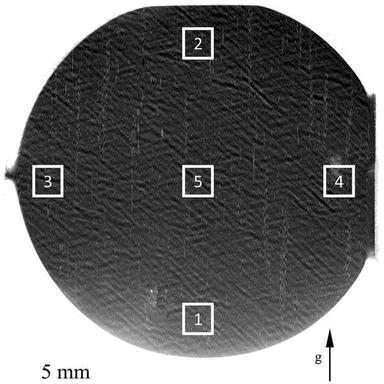
Grazing topograph from the Ga face of a 1-inch ammonothermal GaN wafer (g = 1124; 9.37 KeV) showing that the wafer is of an overall high-quality. Please note that the major streaks observed on the overall image are artifacts from the beamline setup (most likely phase contrast images of inhomogeneities on the beryllium window) and non-defect related. Five boxes, with about 1.7 mm by 2.3 mm each, were chosen to be magnified to do further analysis.